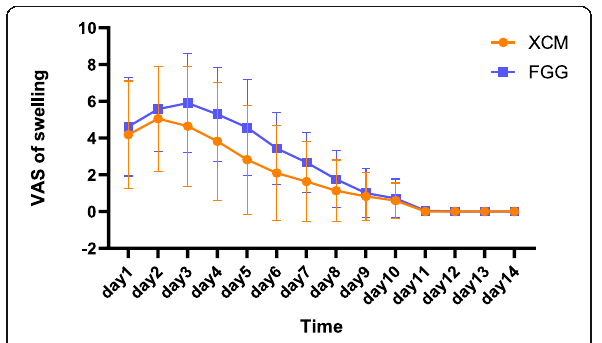
Fig. 3 Patients reported swelling perception during the early healing stages